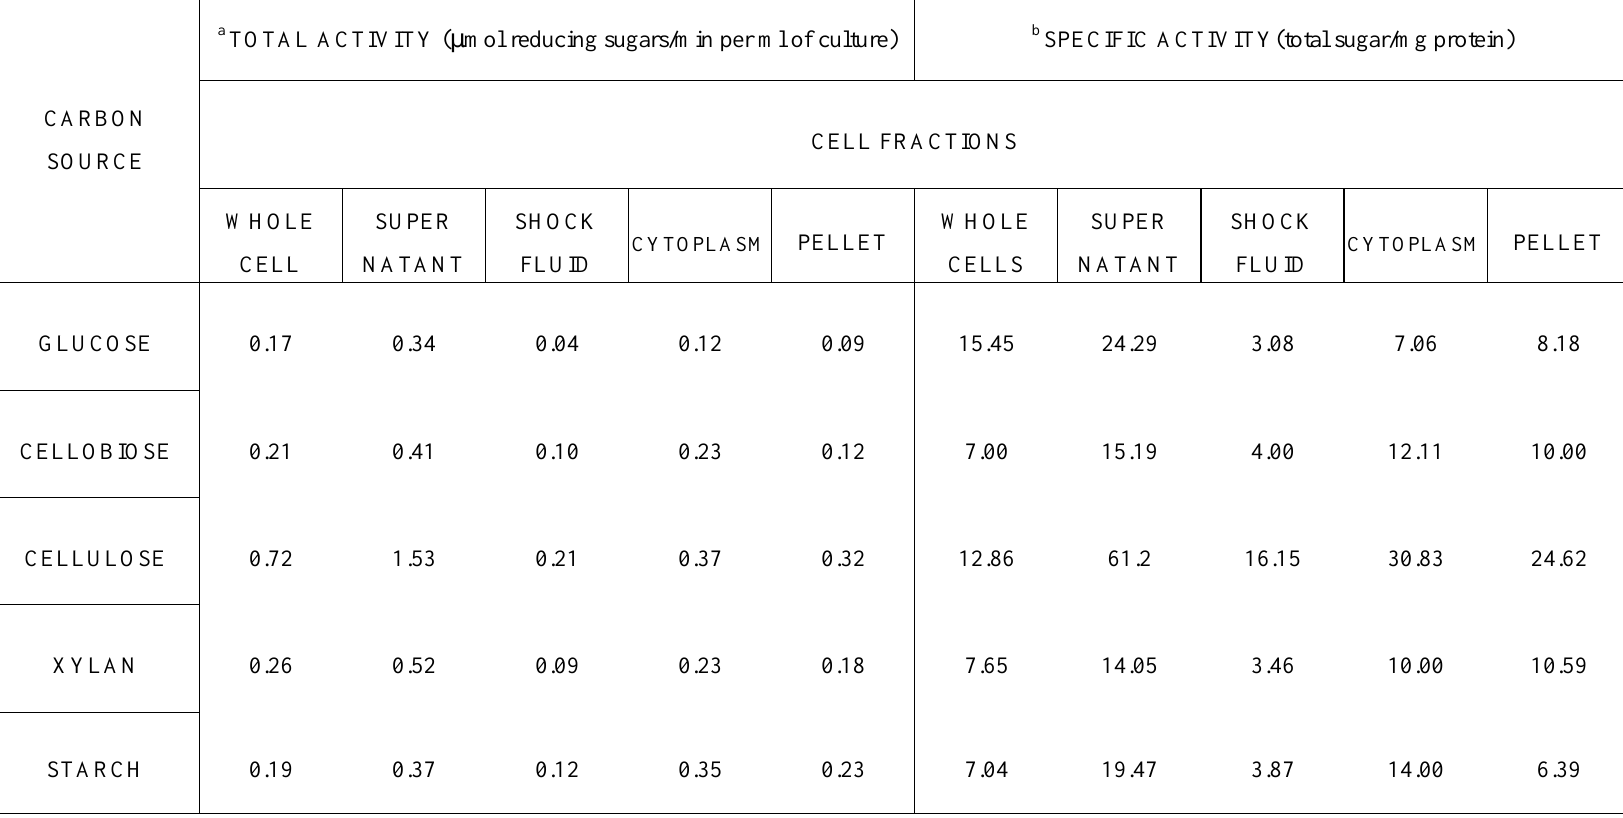
Table 1. Total and specific activities of various cell fractions separated from cells of Cytophaga Hutchinsonii grown on different carbon sources at